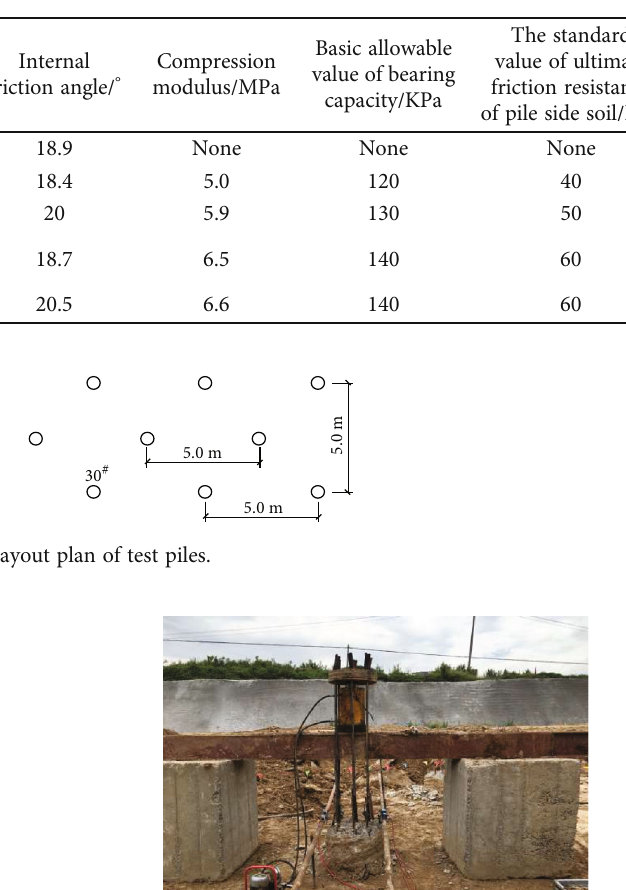
Figure 3: Pro fi le of U-groove of motorway. Table 1: Physical and mechanical parameters of ground strata.